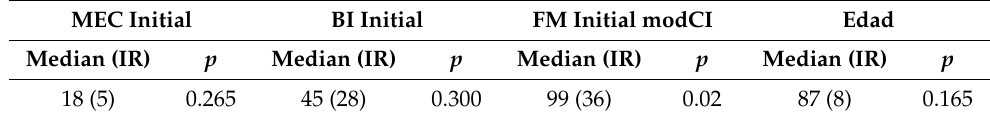
Table 2. Initial comparison between CG and EG.